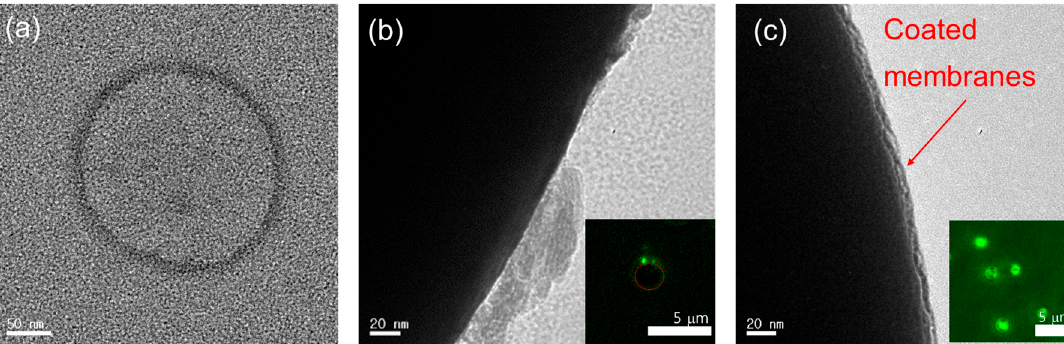
Figure 4. TEM images with uranyl acetate negative staining that depict ( a ) RBC membrane-derived vesicles without the core substrates after sonication, ( b ) a low surface cover ratio of RBC membranes to Si particles (2 μ m), which shows the partial debris of membranes on substrates, and ( c ) a high surface cover ratio of RBC membranes to Si particles with the successful translocation of the membrane onto the Si particles. The inset figures show a confocal image of RBC-membrane-coated hybrid Si particles with the low and high surface cover ratio of RBC membranes to particles in the phosphate buffered saline solution. The membrane was labeled with fluorescence lipids (DMPE-RhB) of 2 μ M.